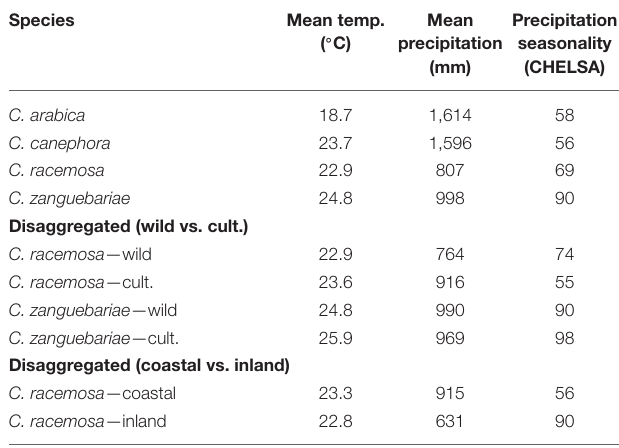
TABLE 3 | Climate profiling summary with mean values and disaggregated mean values for wild and cultivated ( C. racemosa and C. zanguebariae ), and coastal (low elevation) and inland (higher elevation) for C. racemosa